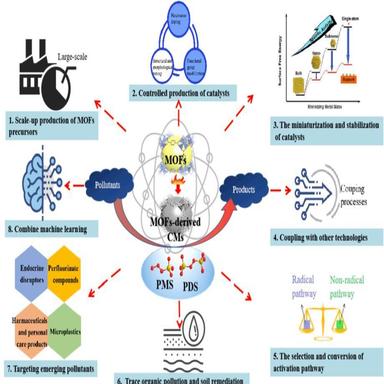
The challenges of MOFs-derived CMs for SR-AOPs in the further development.